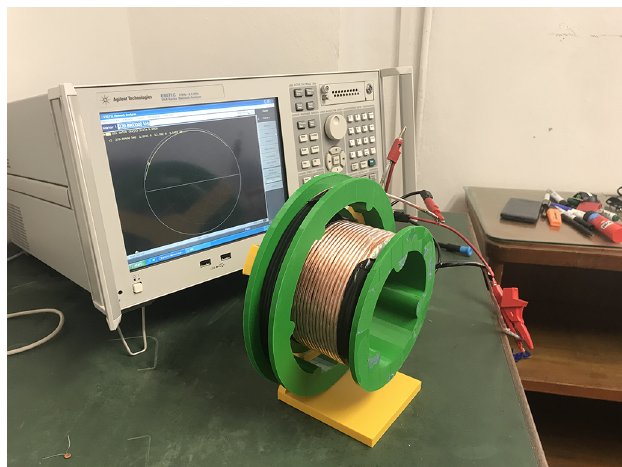
Figure 5. Experimental characterization and validation of the setup.